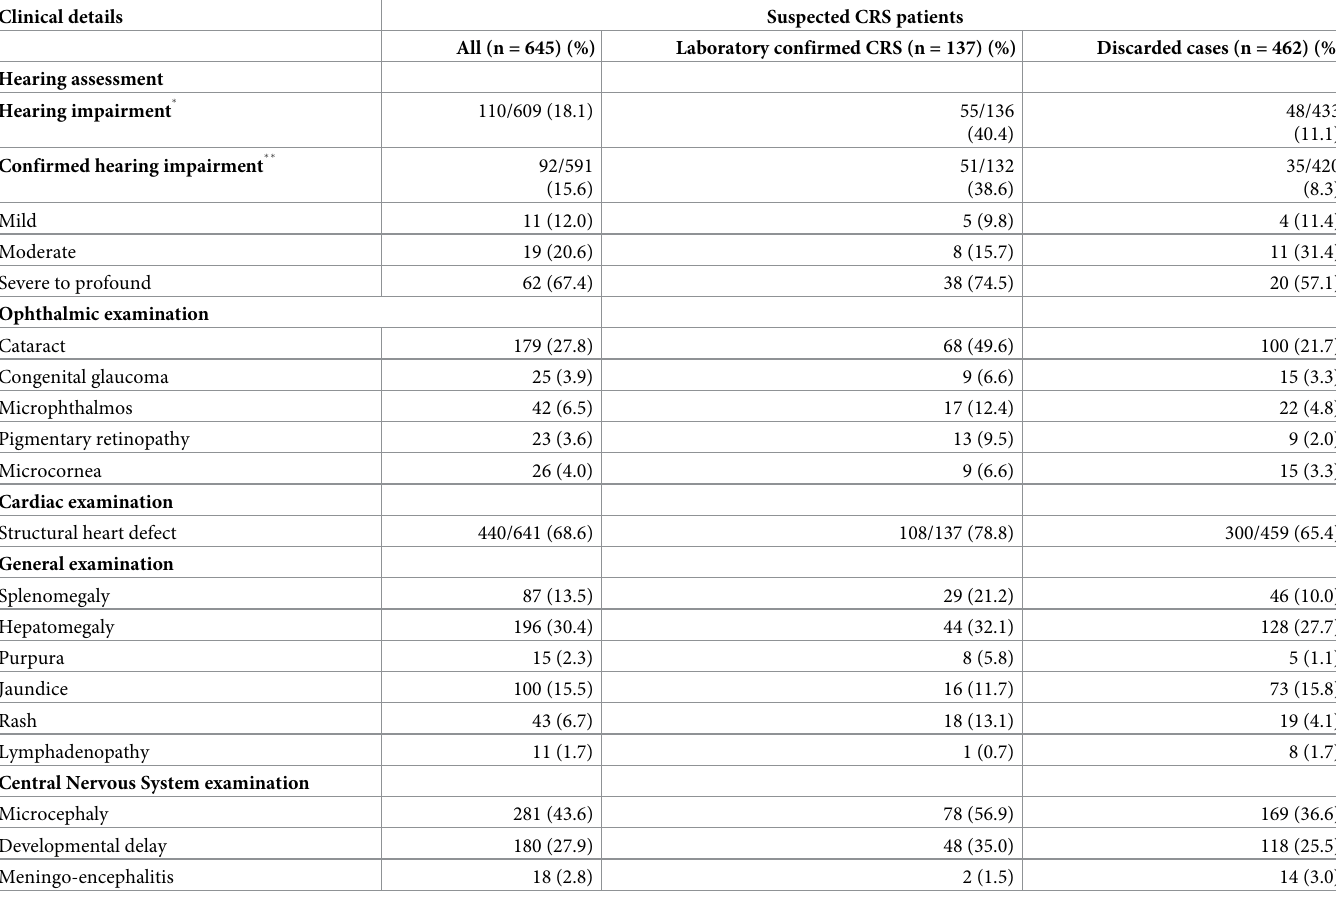
Table 2. Clinical characteristics of suspected and laboratory confirmed CRS